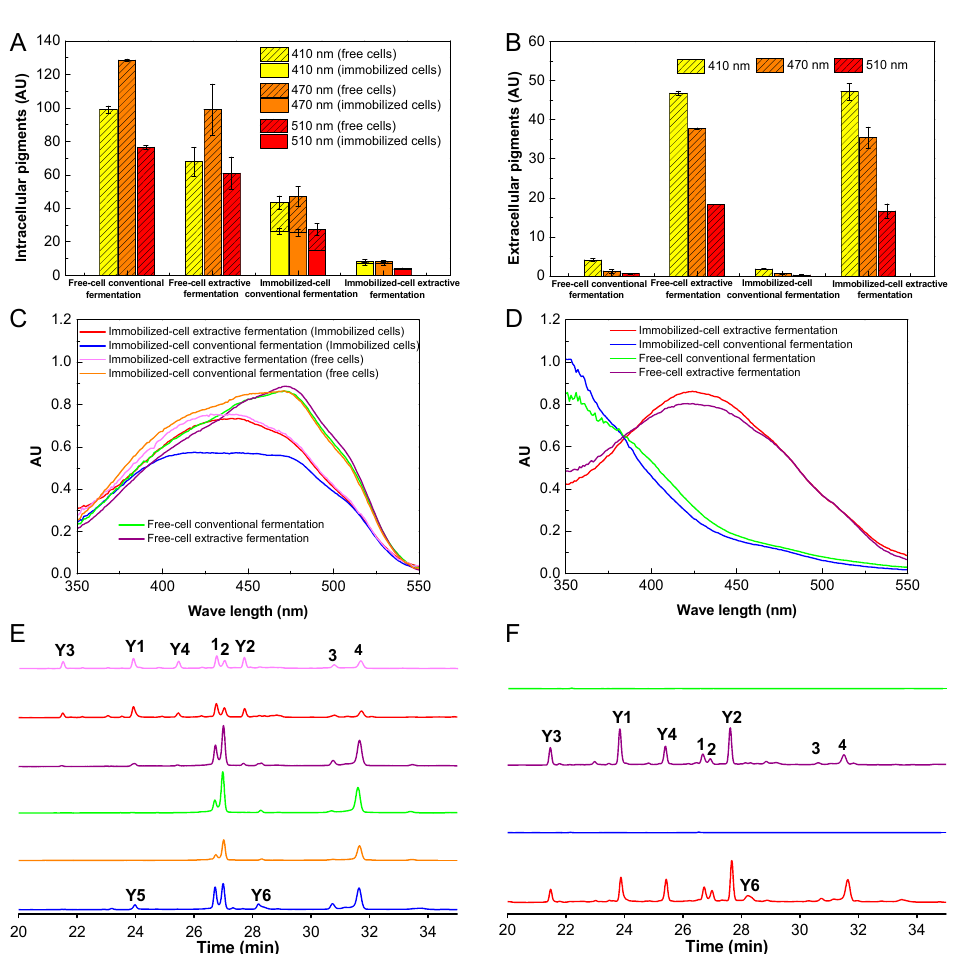
Figure 3. Effects of cell immobilization and Triton X-100 on pigment production. ( A ): Intracellular pigment concentration; ( B ): extracellular pigment concentration; ( C ): visible spectra of intracellular pigments; ( D ): visible spectra of extracellular pigments; ( E ): HPLC profile of intracellular pigments (its legend was the same as ( C )); ( F ): HPLC profile of extracellular pigments (its legend was the same as ( D )).